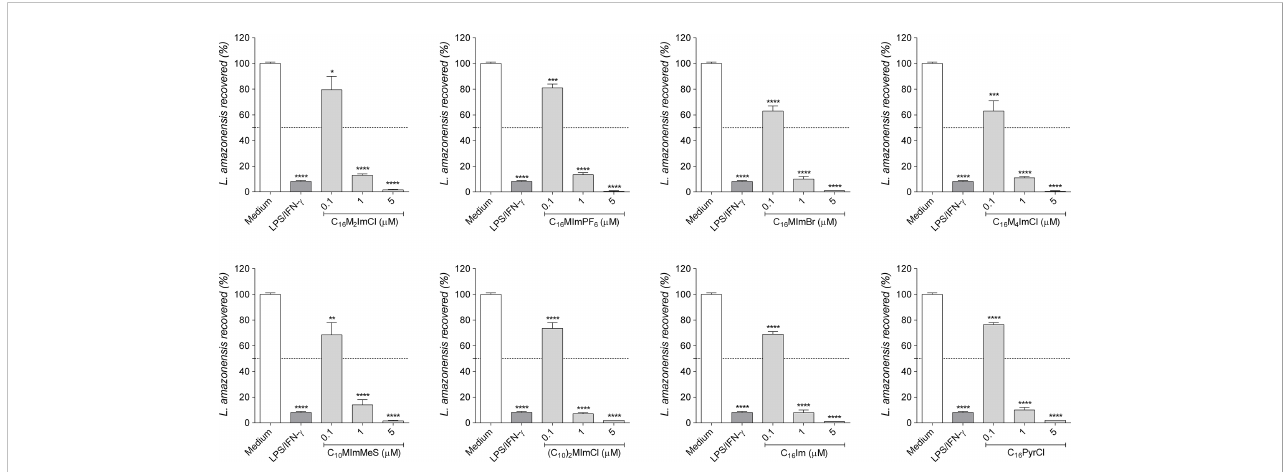
FIGURE 6 Intramacrophage anti-amastigote activity of compounds. RAW cells (2 × 10 5 cells/well) were infected with promastigotes of L. amazonensis (10 parasites/ cell) in the stationary phase (day 5 of culture) and incubated with DMEM (control), lipopolysaccharide (LPS; 10 ng/mL) plus interferon- g (IFN- g ; 1 ng/mL) as positive control, or IS, C 16 Im or C 16 PyrCl at concentrations of 0.1 m M, 1 m M or 5 m M for 48 h. After, cells were lysed, supplemented with M199 30% FBS and cultured at 26°C for 7 days to determine the number of promastigotes recovered using a hemocytometer. Data are expressed as means ± SEM (n = 5). The One-way ANOVA test followed by the Bonferroni ’ s test were applied. *p < 0.05, ** p < 0.01, ***p < 0.001 and ****p < 0.0001 when compared with the medium group (100% parasite recovered).